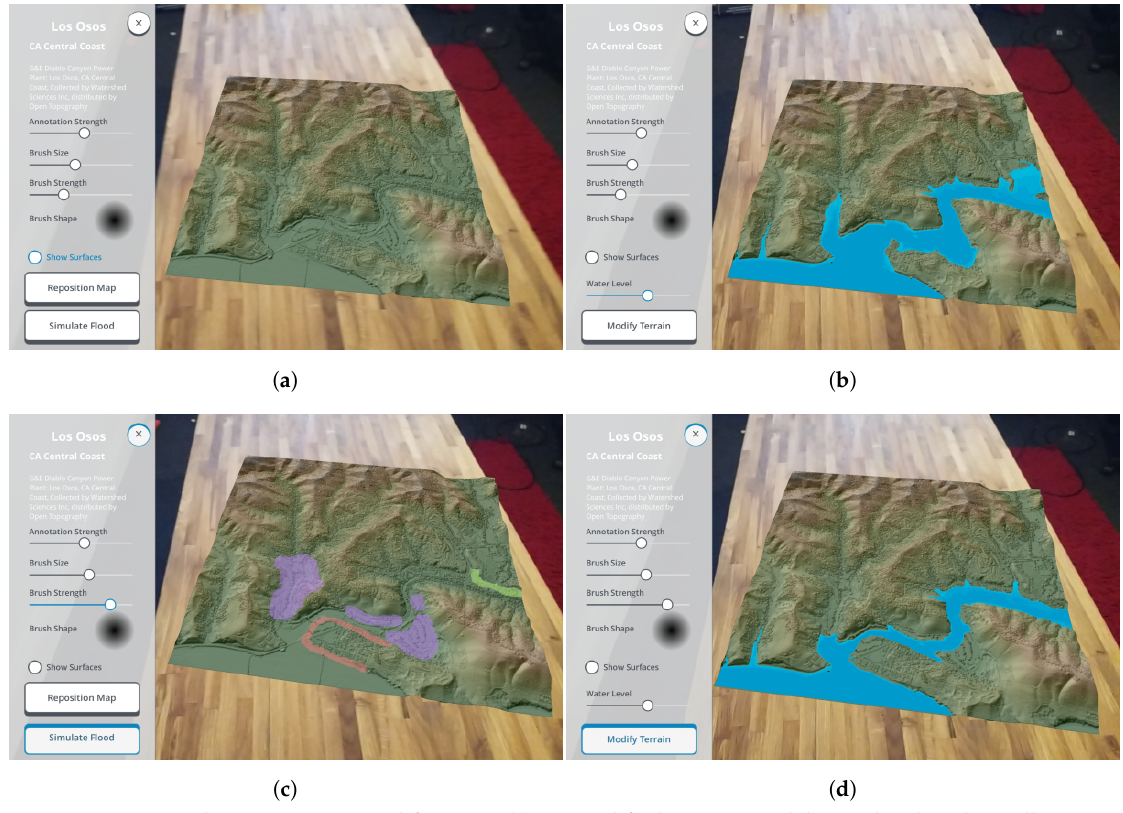
Figure 6. Multi-user terrain modification. ( a ) Unmodified terrain model visualised with satellite imagery. ( b ) Simulated flood event over the unmodified terrain. ( c ) Modification highlights for two users. ( d ) Simulated flood event of modified terrain, showing reduced flood extent due to landscape